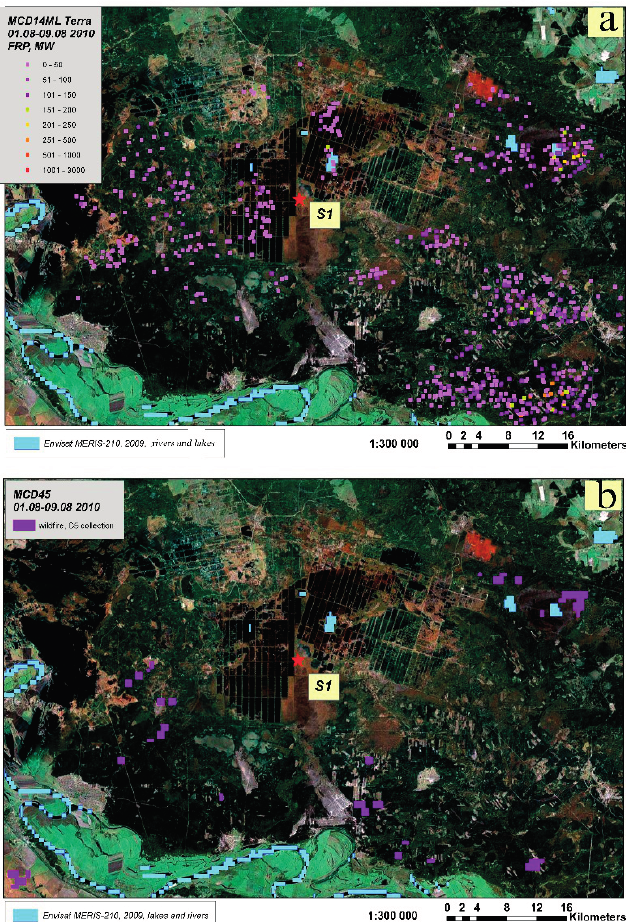
Figure 2. The spatial distribution of MCD14ML ( a ) and MCD45 ( b ) hot spots on the peat land were illustrated on GoogleEarth satellite photos. This peat location in European Russian plain is shown in Figure 1c as “s1” red asterisk. The dark squares indicate the peat mining. The drainage systems appear as blue color lines between the dark squares. The water surface as a map layer was added according to Envisat/MERIS–210 satellite data at 2009 year status. The hot spot locations, which were obtained during temporal period from 1 August to 9 August 2010, by MODIS/Terra satellite data (MCD14ML, method AF), are displayed in (a) as different color points, graduated by FRP values. To compare the wildfire localizations by using the AF method and by the BA (MCD45) method, the areas burned during the temporal period from 1 August to 9 August 2010 are shown in